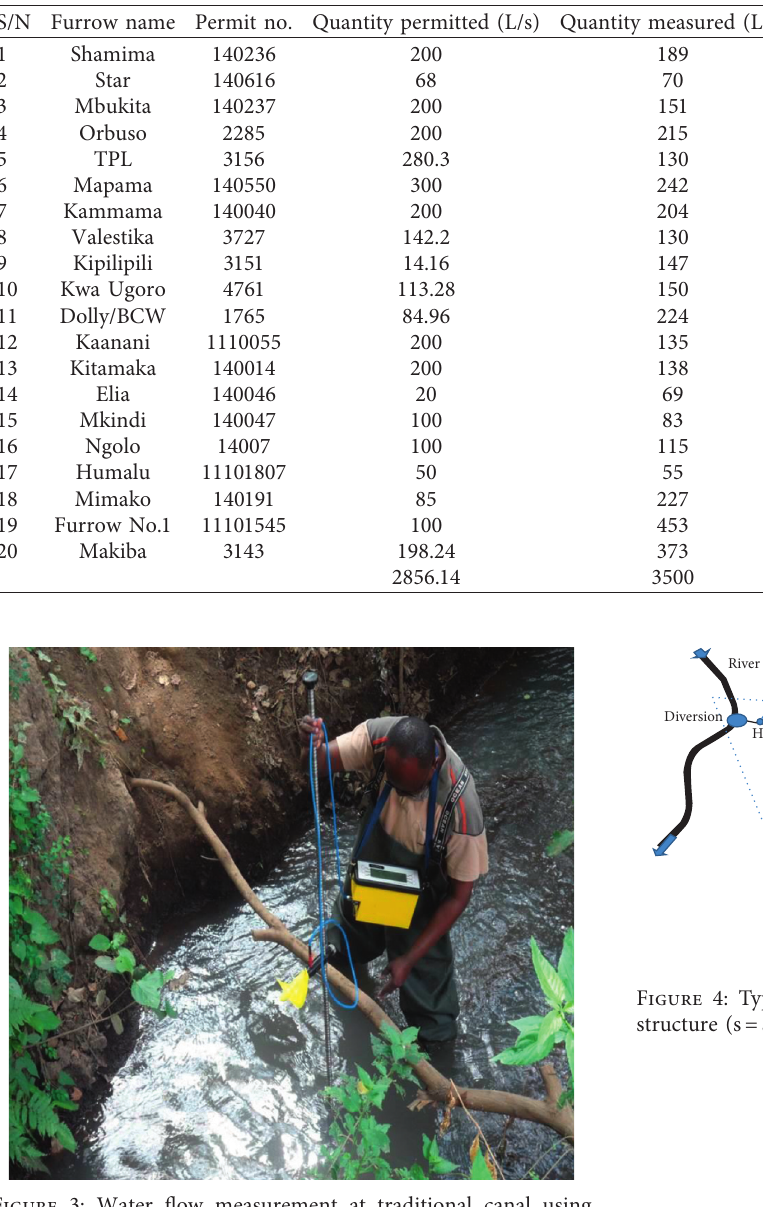
Table 1: List of irrigation furrows with measured water abstraction at the intakes and water permits in Sept 2017.